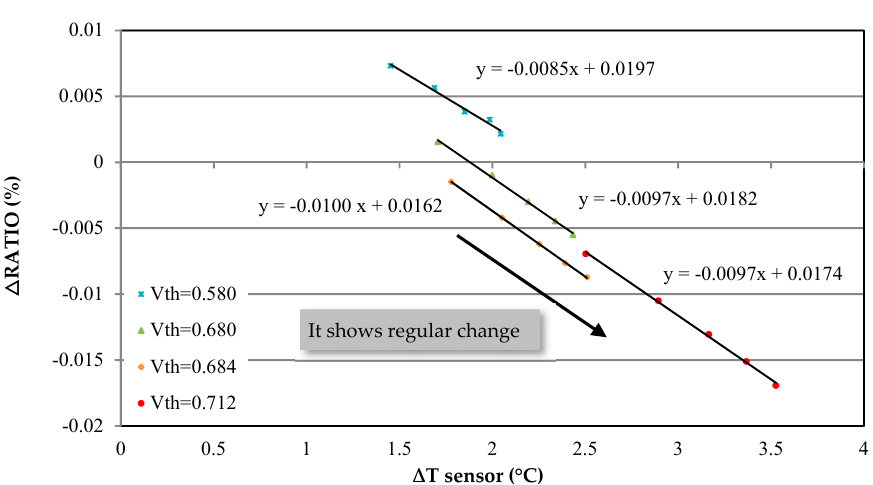
Figure 8. Relationship between Ratio and T sensor without temperature compensation.